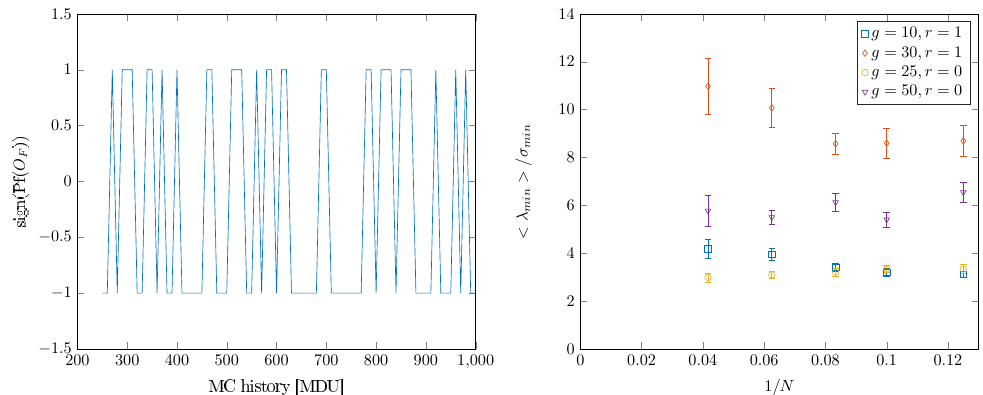
Figure 2 . Left panel: Monte Carlo history for the sign of the Pfa(cid:14)an of O of the coupling. The strong oscillatory behavior indicates a severe sign problem. Right panel: the lowest eigenvalue (cid:21) min for the squared fermionic operator O y zero, a statement which then also holds for O F . The variance is de(cid:12)ned by (cid:27) 2 In the region of parameters explored, no zero eigenvalues for det O F appear, indicating that for the real Pfa(cid:14)an Pf O F no sign (cid:13)ips should occur. right panel of (cid:12)gure 2 shows that the smallest eigenvalues of ^ O y